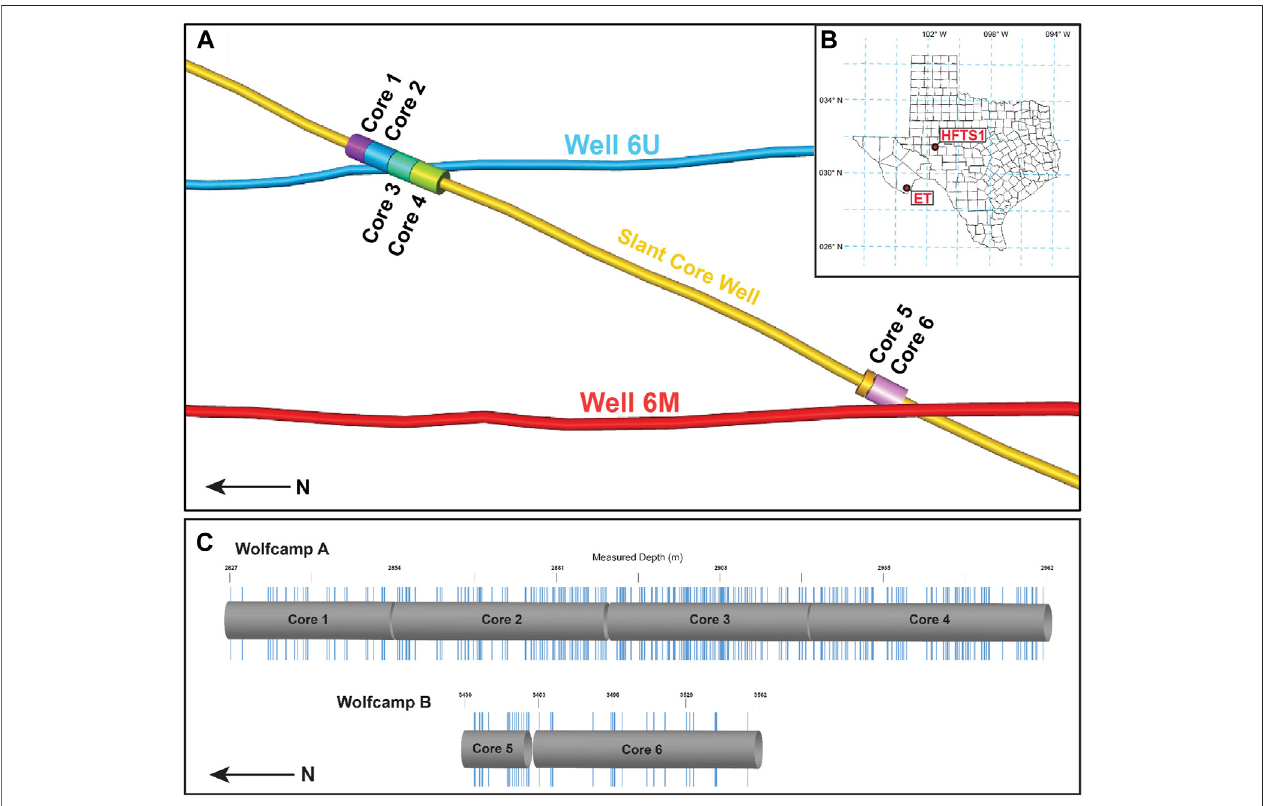
FIGURE2|(A) Schematicview,lookingEast,oftheslantcorewellandthe6Uand6 Mhorizontalwells,showingthelocationofthe6discretecoresections.The6U and 6 M wells are spaced 98 m apart vertically, and 100 m apart horizontally. The vertical dimension in this fi gure has been stretched ×20 and wellbore and core diameters have been increased for visualization purposes. (B) Map of Texas and the surrounding area, with the HFTS1 location labeled in West-Central Texas, and the Ernst Tinajalocationlabeled tothesouthneartheMexicoborder inWest Texas. (C) Distribution ofhydraulicfracturesidenti fi edbyGaleetal.(2018)ineach ofthe6 slant core